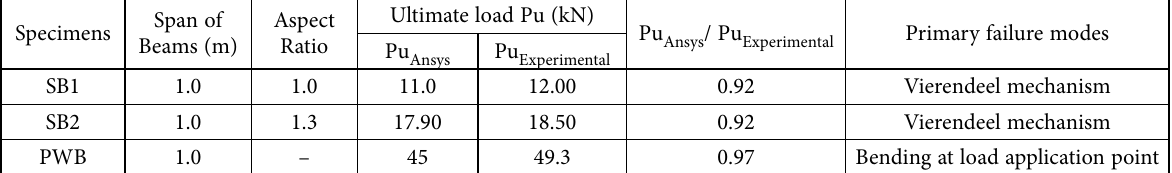
Table 2. Comparison of experimental and finite element ultimate load